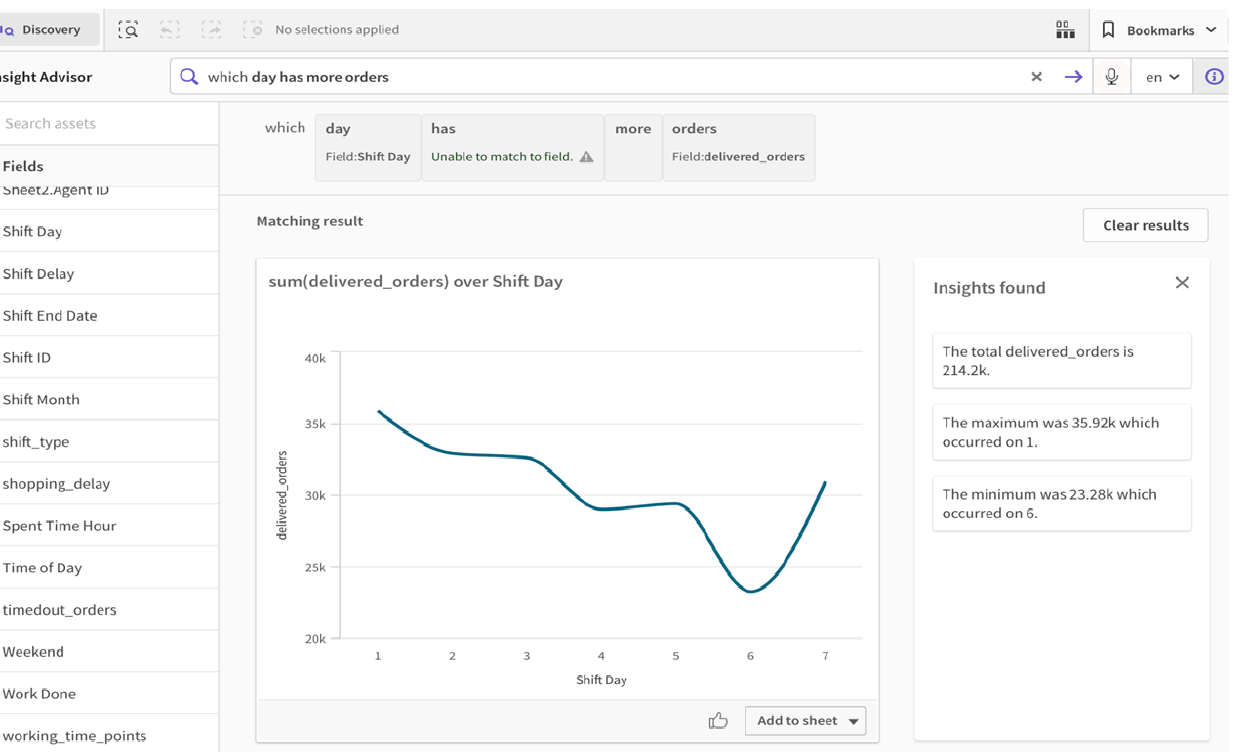
Figure 10. Natural language understanding of the user ’ s query in Qlik Sense with the AA approach.